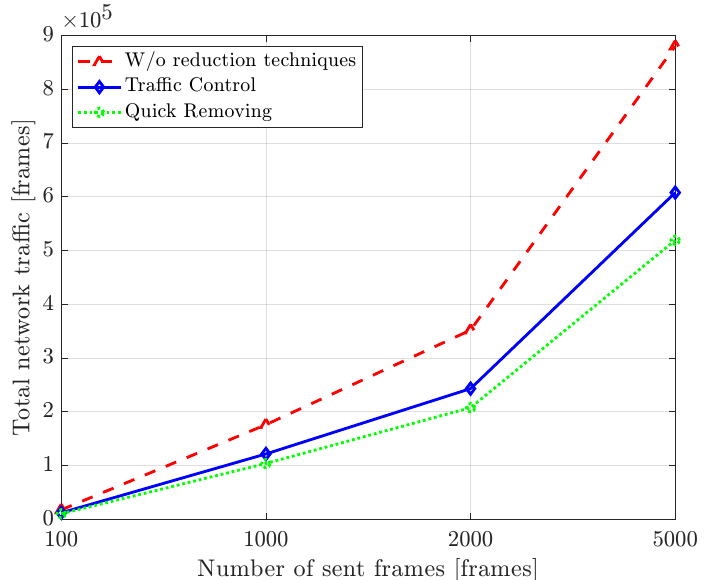
Figure 7. Traffic-reduction performance against numbers of sent frames for the conventional